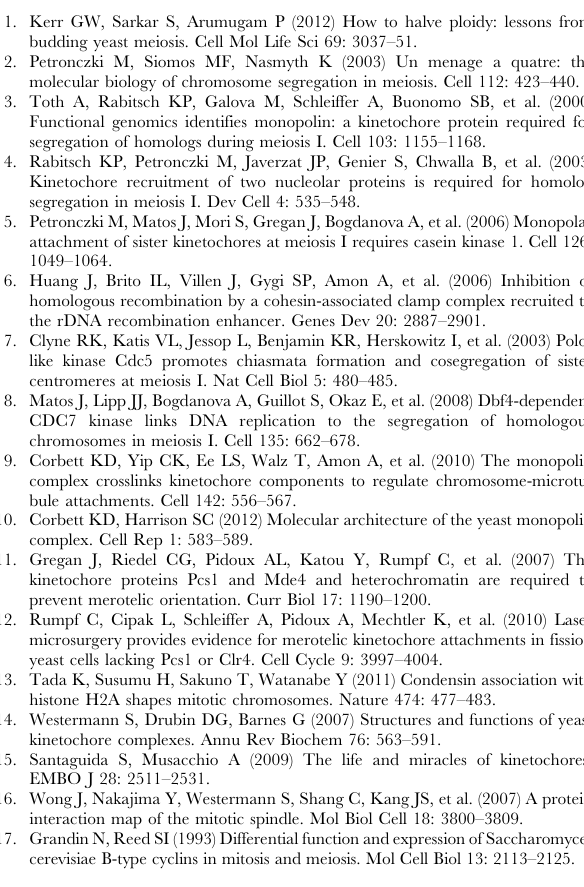
Table S1 All yeast strains are derivatives of SK1 and have